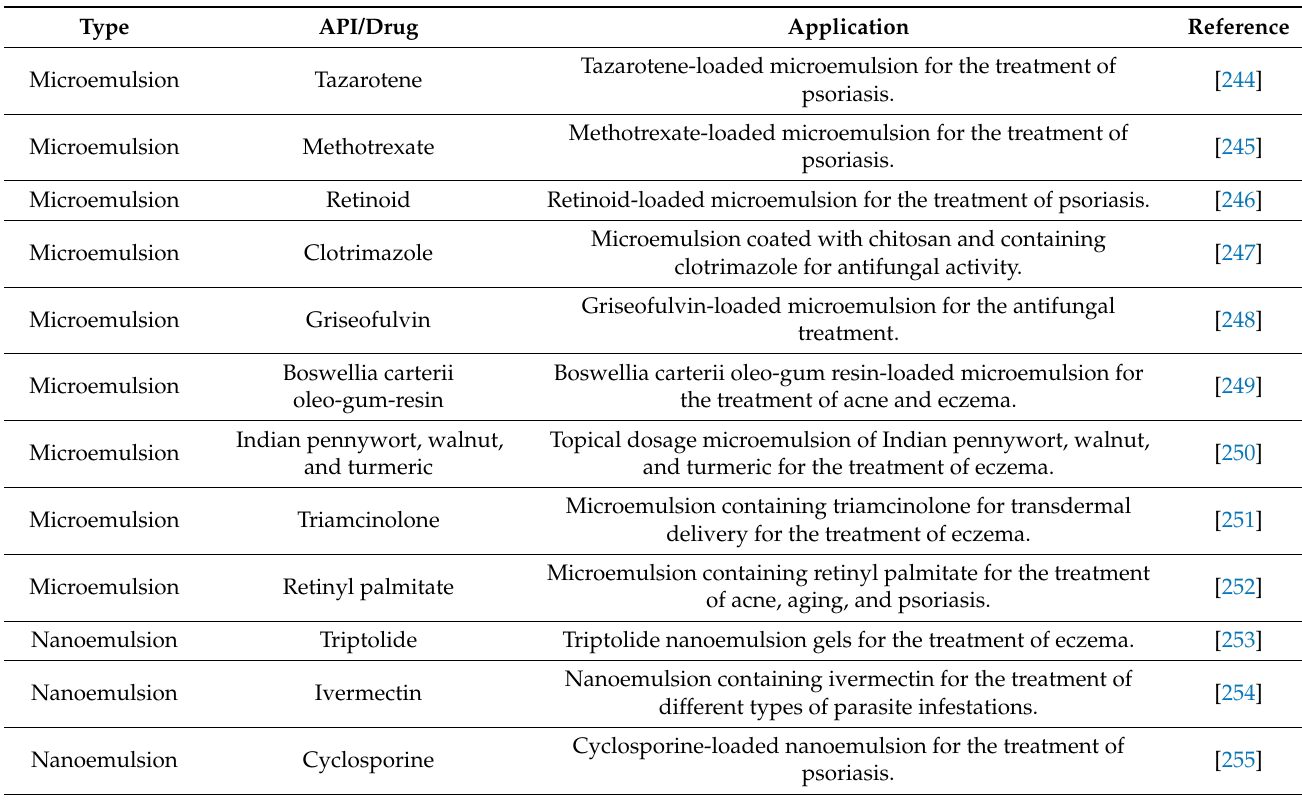
Table 7. Application of microemulsions and nanoemulsions DDS for the treatment of skin disorders. Type API/Drug Application Reference Tazarotene-loaded microemulsion for the treatment of Microemulsion Tazarotene